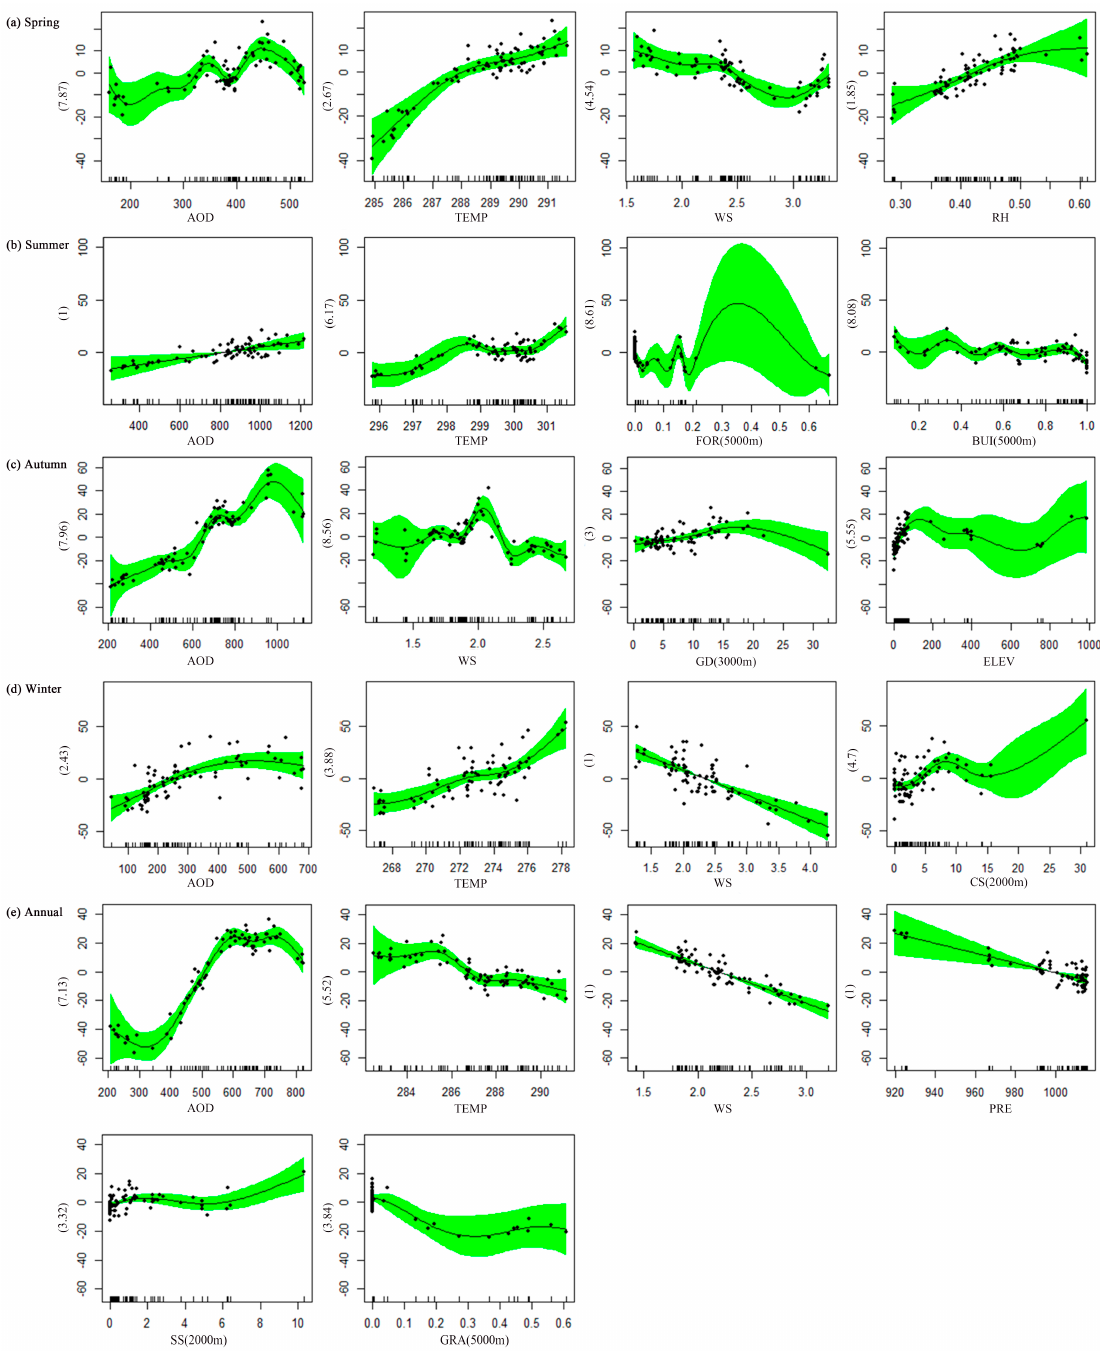
Figure 3. Partial response plots of PM 2.5 predictors. The individual smoothed curve for each predictor variable is shown as solid lines, with 95% confidence limits shown as shaded areas. The x -axis represents the frequency of data; the y -axis represents the marginal effects. Estimated degrees of freedom for each smooth term are given as the number in y -axis caption. ( a – e ) are partial response plots for GAM model of spring, summer, autumn, winter, and annual, respectively. AOD = aerosol optical depth; WS = wind speed; TEMP = temperature; RH = relative humidity; PRE = atmospheric pressure; GD = percentage of all ground dust area; CS = percentage of construction site area; SS = percentage of stacked substance area; BUI = percentage of built-up area; FOR = percentage of forests area; GRA = percentage of grasslands area; ELEV = elevation; and PM = number of papermaking plants.